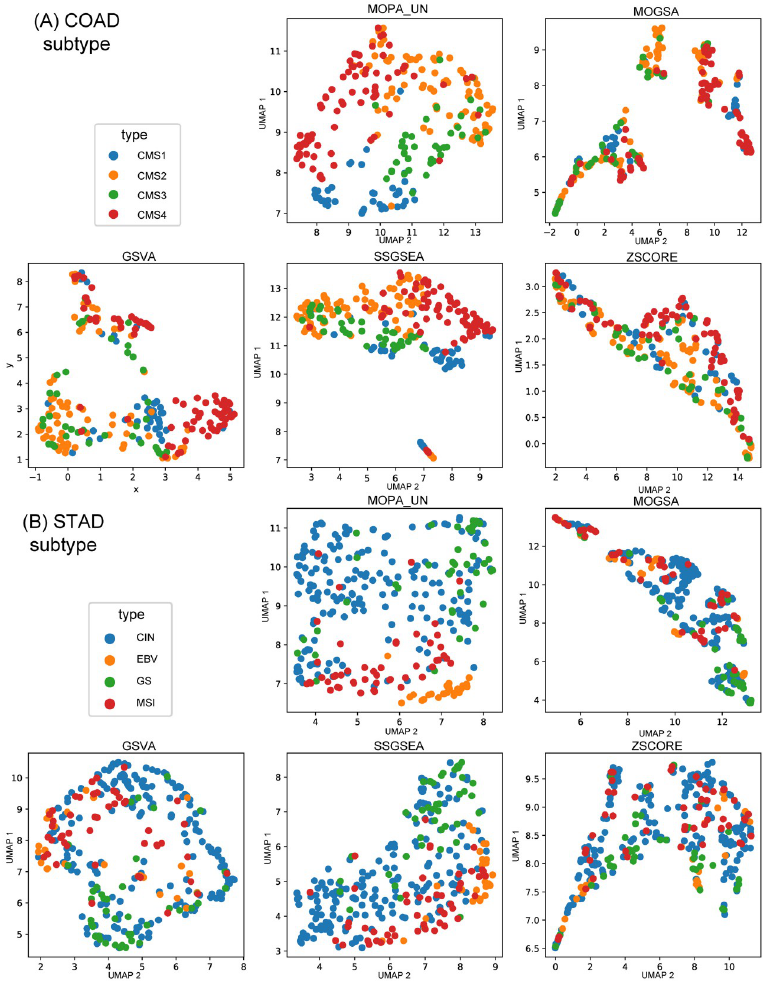
Fig 10. The performance comparison between the five different pathway scoring methods. (A) COAD subtype color coded UMAPs and (B) STAD subtype color coded UMAPs.